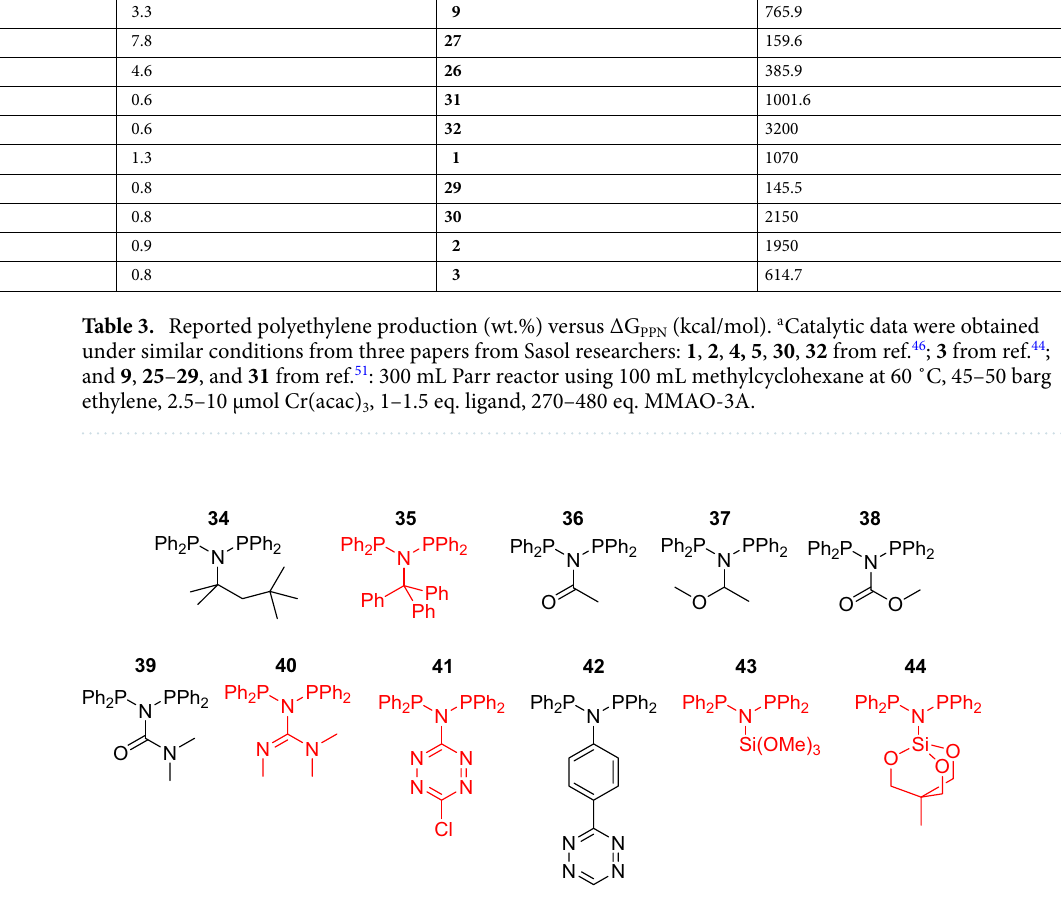
Figure 6. Novel ligand candidates with ΔG PPN < 1 kcal/mol. Black structures are calculated to have positive ΔG PPN ; red structures have negative ΔG PPN .